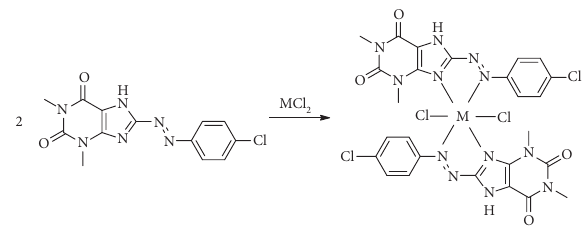
Scheme 2: Preparation of CPAT complexes for Co(II) and